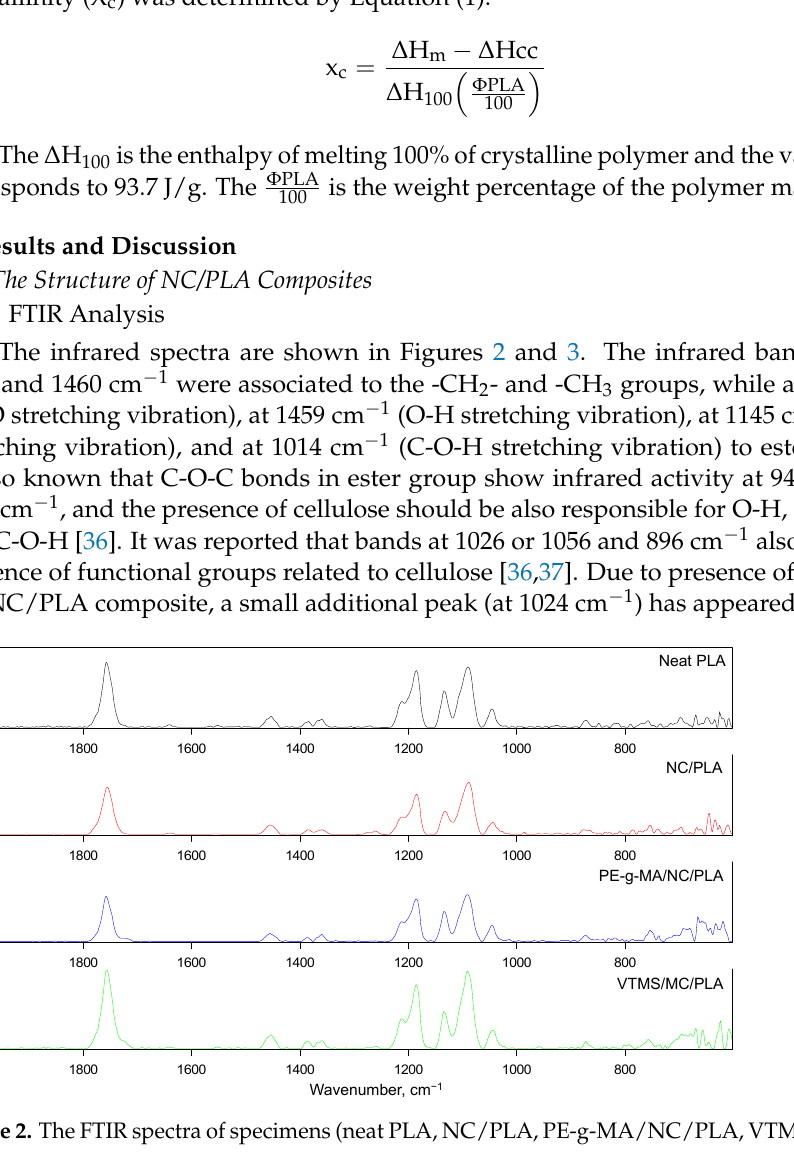
Figure 3. The FTIR spectra of specimens (PEG ‐ 300/NC/PLA, PEG ‐ 2000/NC/PLA, OMAC/NC/PLA, OMACE/NC/PLA). Successful chemical reactions were proposed in VTMS/NC/PLA, because the Si ‐ O ‐ Si and C ‐ Si ‐ C groups are responsible for infrared bands between 800–950 cm − 1 and at 663 cm − 1 , respectively. The application of PEG resulted in less chemical reactions than in the aforementioned cases, and there were no significant differences in infrared spectra of PEG ‐ 300/NC/PLA and PEG ‐ 2000/NC/PLA composites. It is an important observation that some new infrared bands were found both in the spectra of NC/PLA containing α‐ olefin ‐ maleic anhydride copolymer and α‐ olefin ‐ maleic anhydride ester copolymer (at 1132, 1045, 1089, 1211, 1184, 1360, 1313, 1427, 1452, 1750, and 1790 cm − 1 ), which refers to the formation of new chemical bonds. 3.1.2. Scanning Electron Microscopy (SEM) Analysis The morphology of broken surface of different NC/PLA composites was investigated by a FEI Thermo Fisher Apreo S LoVac instrument. The SEM micrographs are summa ‐ rized in Figure 4.